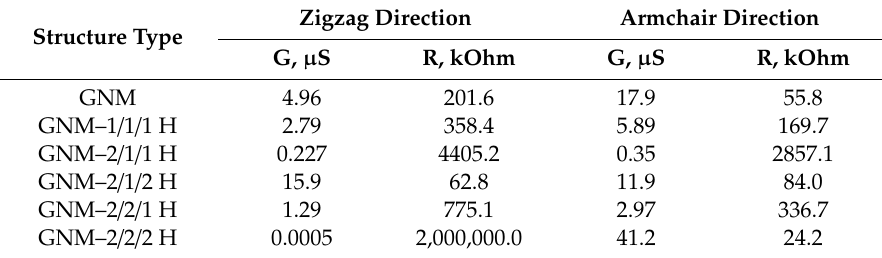
Table 2. Electroconductive characteristics of GNM with various types of hydrogenation of the nanohole